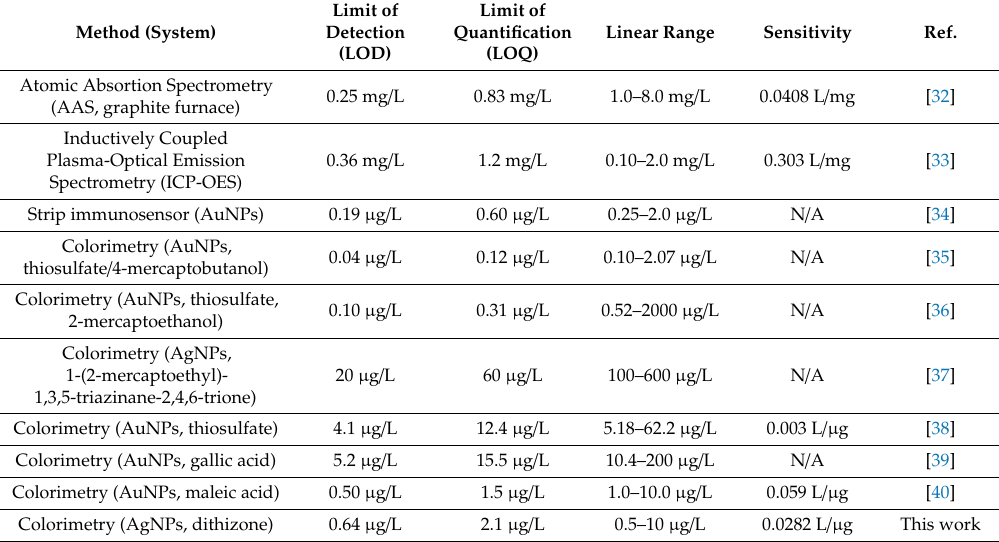
Table 1. Representative analytical characteristics of the Pb 2 + analytical